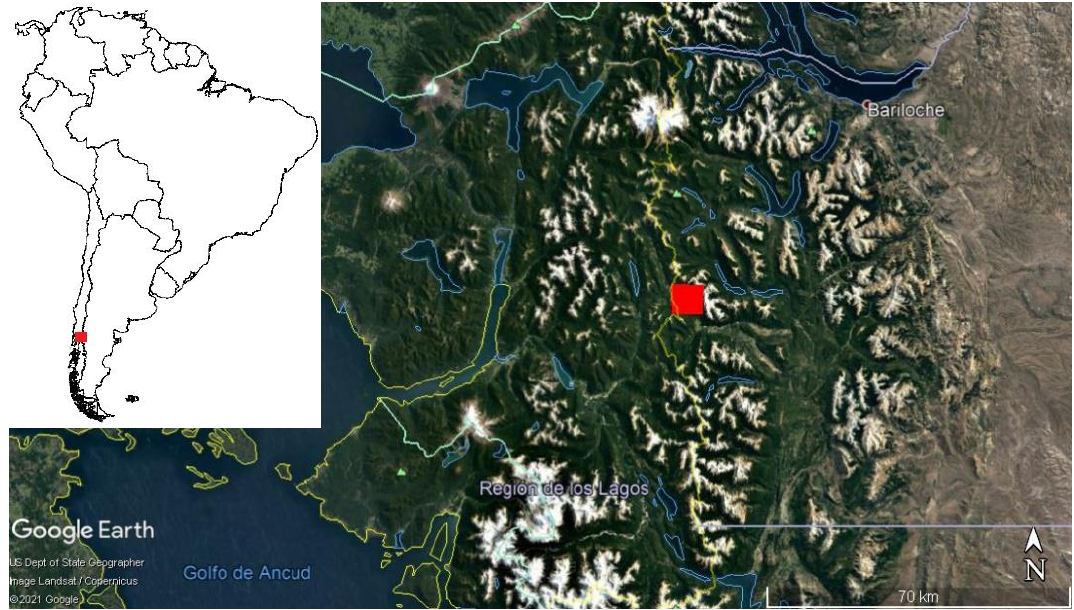
Figure 2. Location of the study area (red) (41°31 ′ S and 71°49 ′ W) in El Manso Valley, Province of Río Negro. South America`s map source: [12].